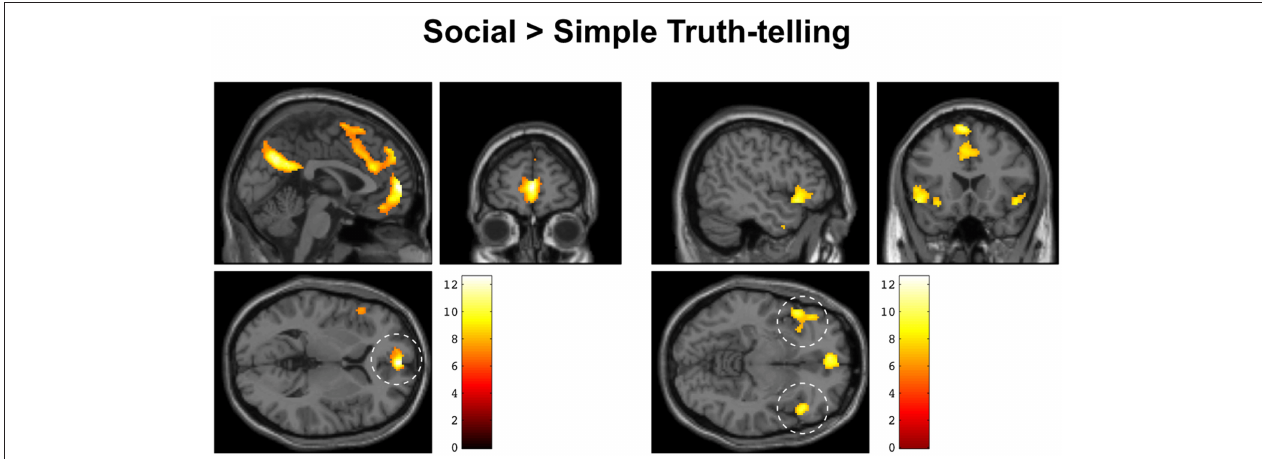
FIGURE 3 | Increased BOLD activity during social > simple truth telling overlaid on an anatomical MRI of a single subject in MNI space. Left : sagittal, coronal, and axial sections centered on the medial prefrontal activation (dashed circle). Right : sagittal, coronal, and axial sections centered on the activation in bilateral anterior insula and inferior frontal gyrus (dashed